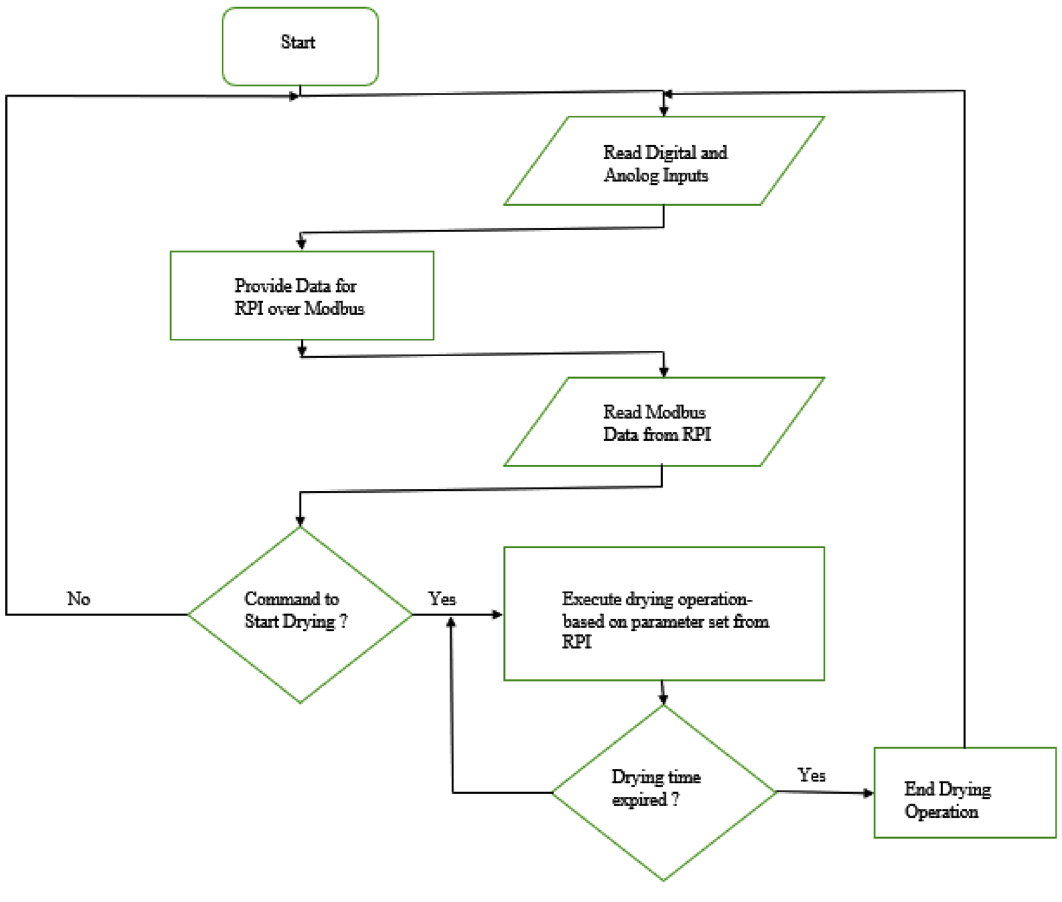
Figure 9. PLC program flow chart.